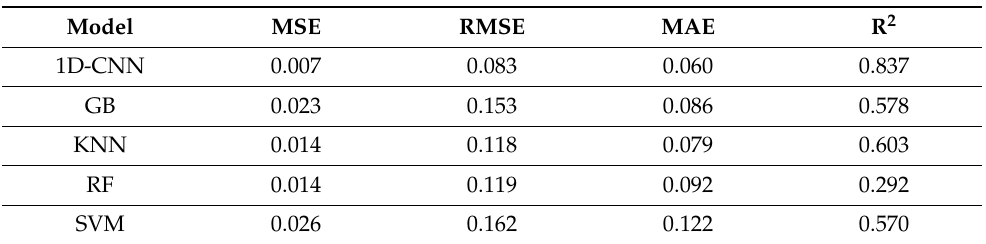
Table 16. Comparative model validation result of the sand pack test with SAND_PROD_PER_AREA as the